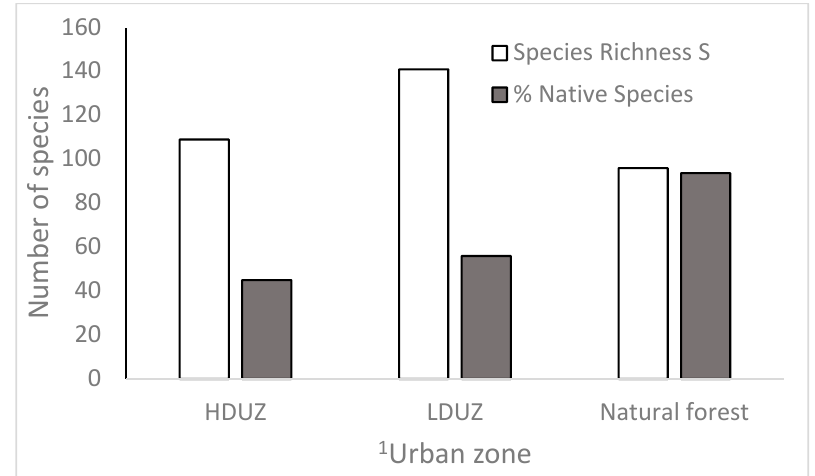
Figure 6. The species richness and proportion of native species in the urban zones in Kumasi. 1 HDUZ—high density urban zone, LDUZ—low density urban zone and natural forest (Owabi